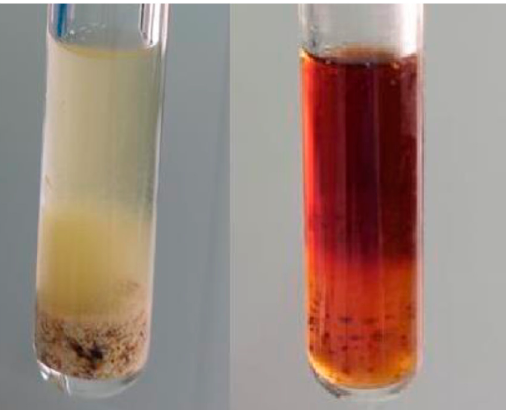
Figure 6. Images of the extracts obtained after undergoing the MAE process with Et30DW ( left im- age) or with Bet: 2But [1:4] ( right image). MAE conditions: 3 min at 900 rpm, 100 °C, and 1:10 F:S ratio.